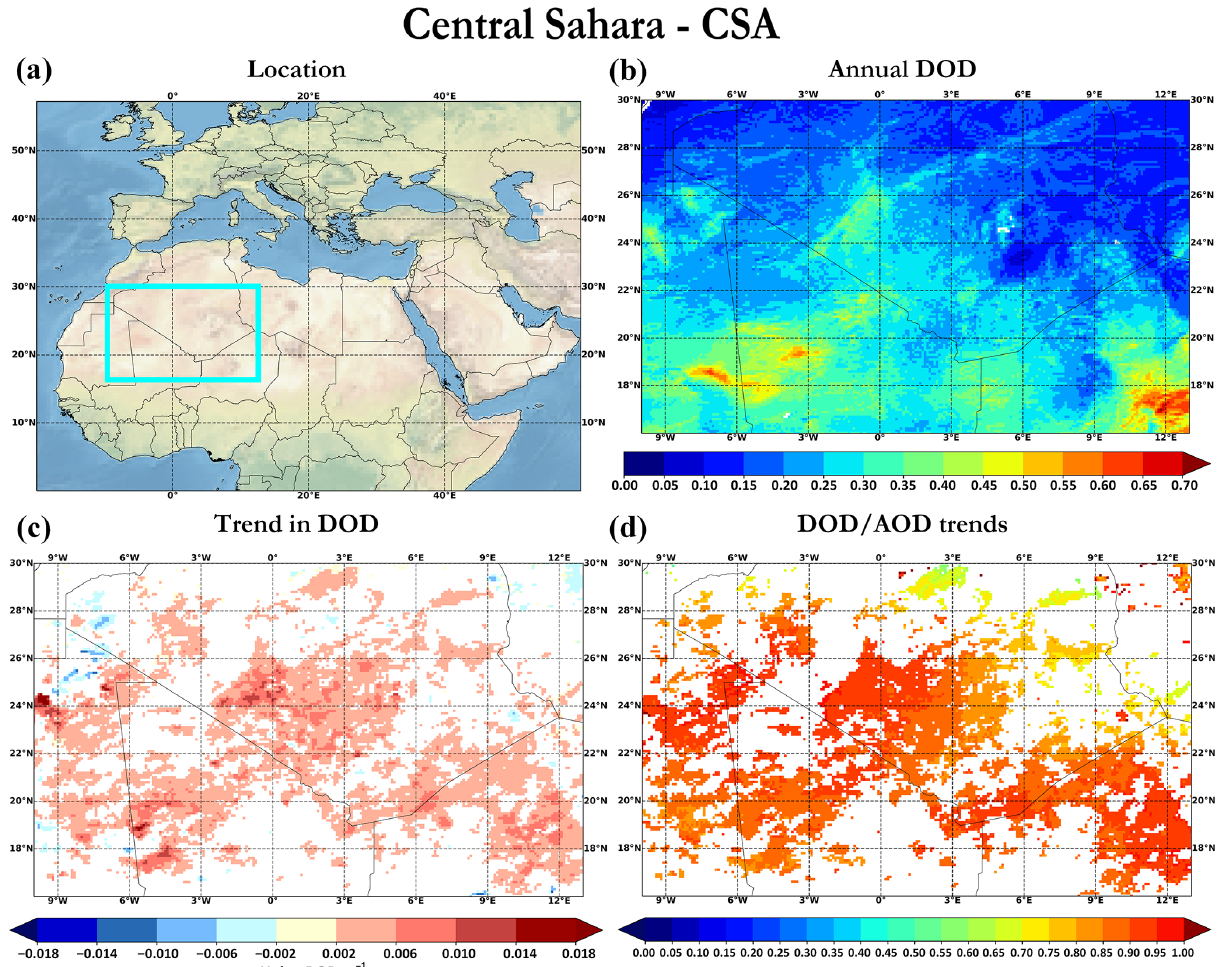
Figure 10. (a) Geographical boundaries, (b ) annual DOD, (c) DOD geometric trends and (d) DOD-to-AOD trend ratios for the central